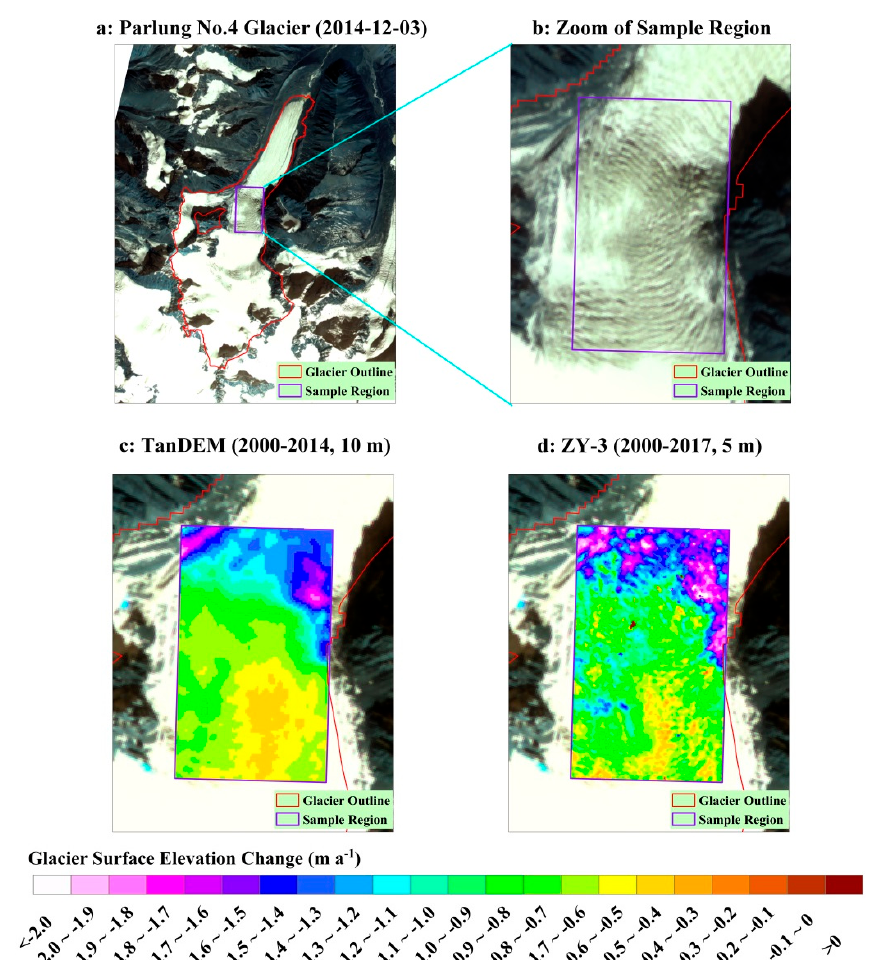
Figure 15. The detail comparison of glacier elevation change derived by TanDEM-X and ZY-3 TLA data for the Parlung No.4 glacier. ( a ): overview of the Parlung No.4 glacier (the basemap is the 8 m spatial resolution Gaofen-1 true color image with band 4 (R), band 3 (G) and band 2 (B) composition on 3 December, 2014); ( b ): zoom figure of the sample region; ( c ) and ( d ): the annual glacier elevation change derived by TanDEM-X in 2000–2014 and ZY-3 TLA data in 2000–2017; their spatial resolutions are 10 m and 5 m, respectively.